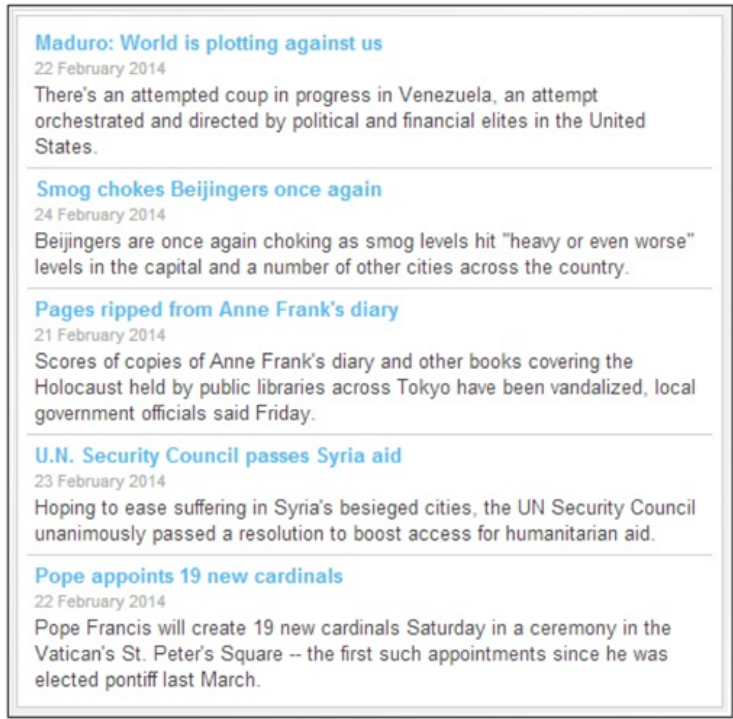
Figure 8. For news, we built a web service that brings data from different RSS